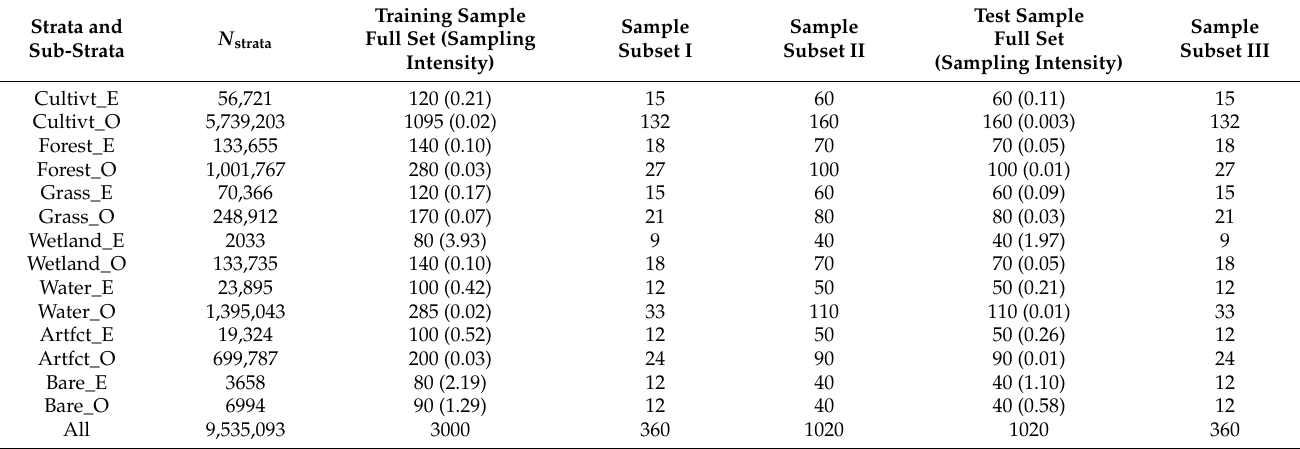
Figure 2. GlobeLand30 2010 land cover map for Wuhan, China. Table 1. Model-training sample full set and subsets I and II, the test sample (for model testing and area estimation), and sample subset III (for area estimation).